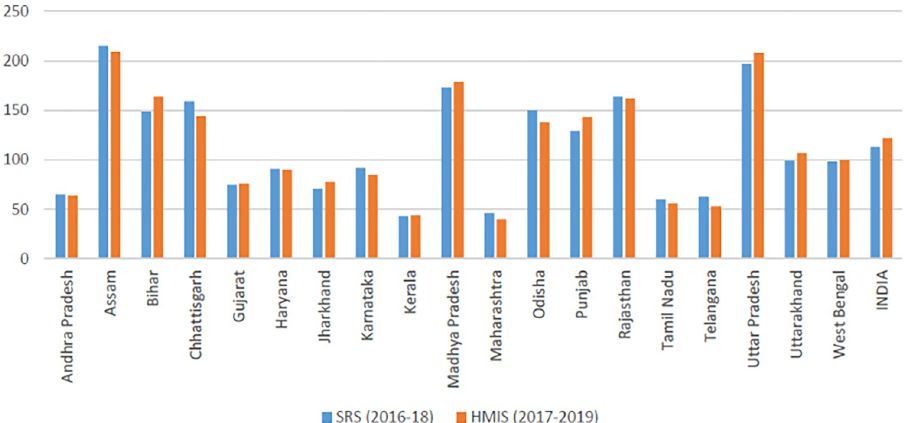
Fig 5. Correspondence between MMR estimates from SRS and